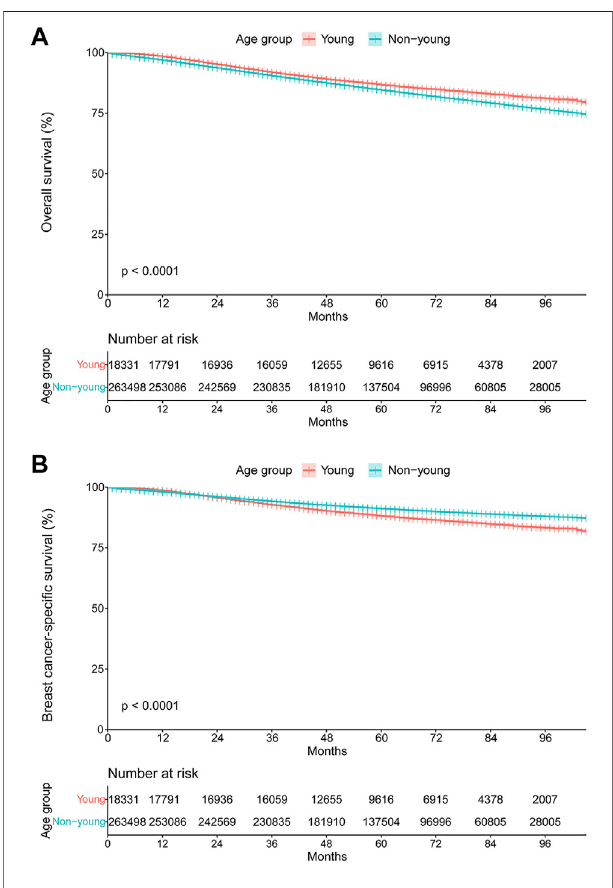
FIGURE 5 | Kaplan – Meier curves of (A) overall survival and (B) breast cancer-speci fi c survival strati fi ed by age group.